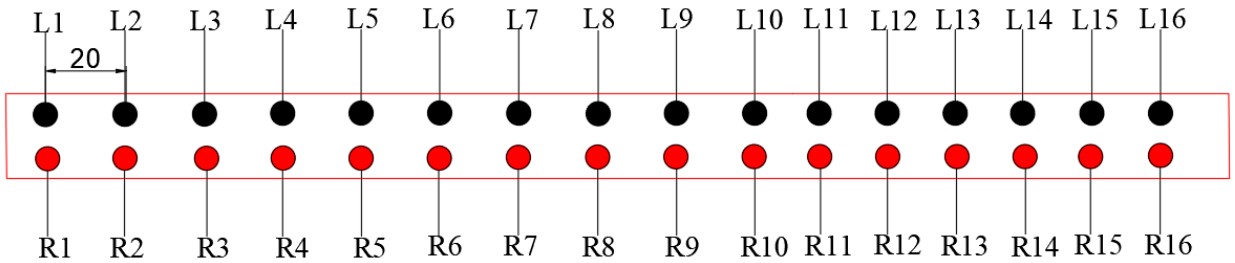
Figure 11. Arrangement of monitoring points for bending settlement value (unit: m).